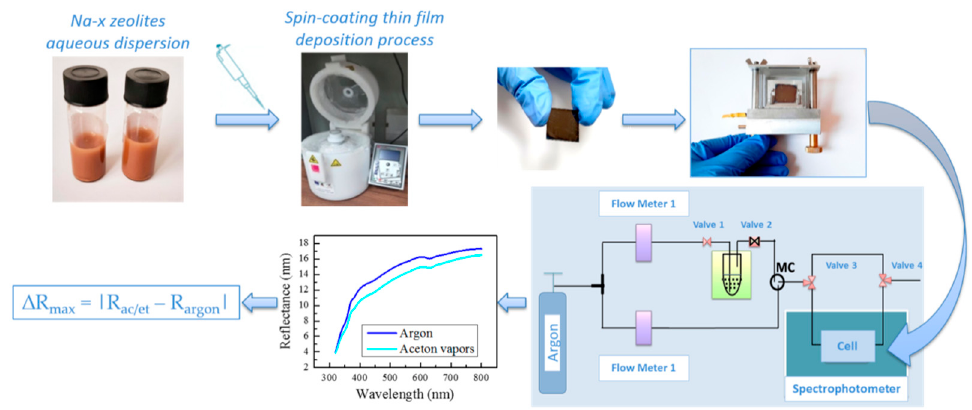
Figure 1. Schematic structure of the process of deposition and testing the sensing properties of the films toward acetone or ethanol vapors.